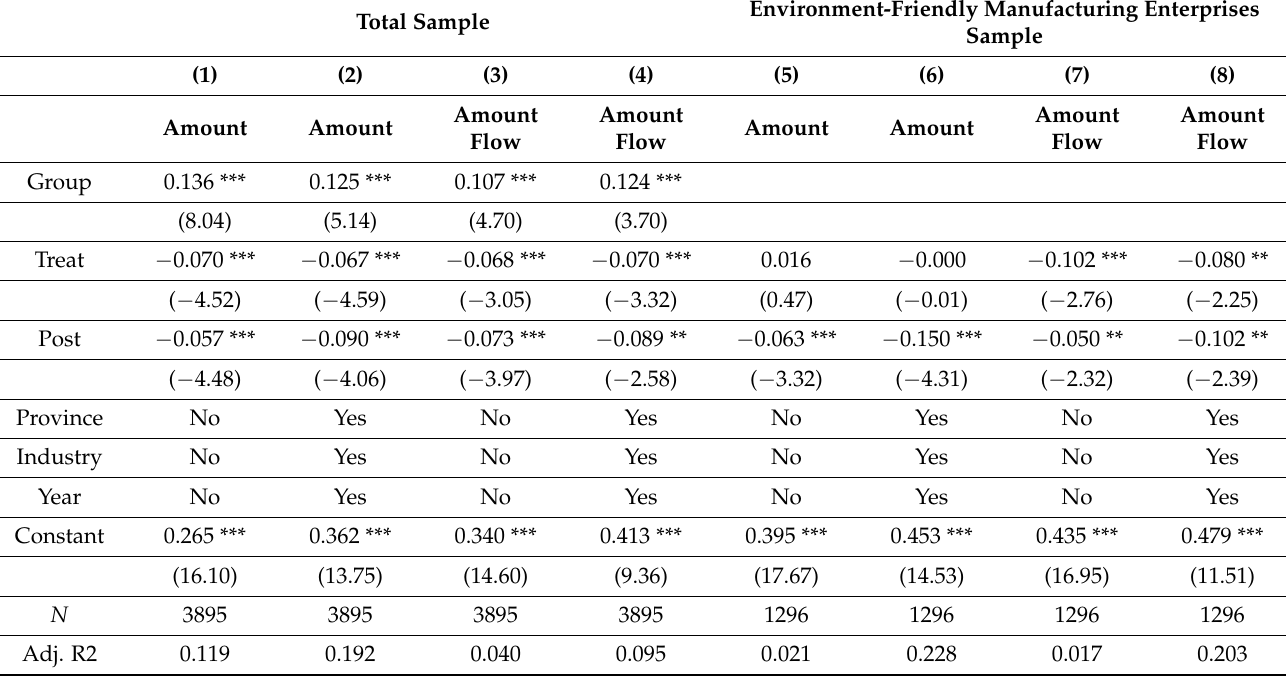
Table 2. Regression results of direct effects of main